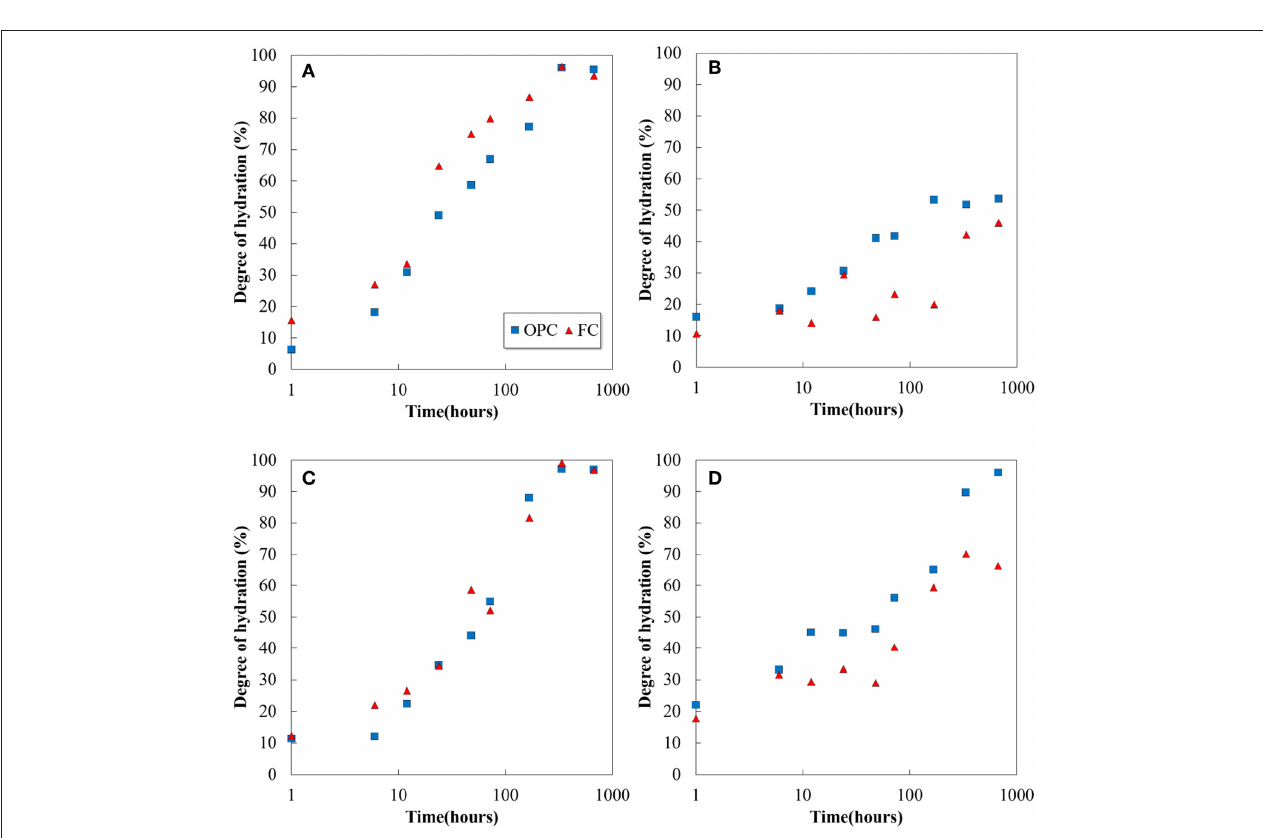
FIGURE 2 | Hydration of (A) C 3 S, (B) C 2 S, (C) C 3 A, and (D) C 4 AF in the cements as a function of time from the XRD/Rietveld analysis.